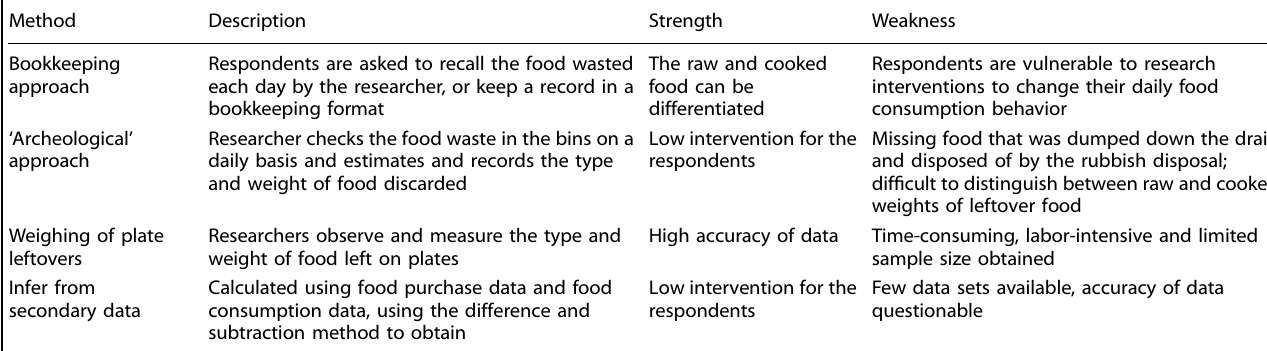
Table 1. Food waste accounting